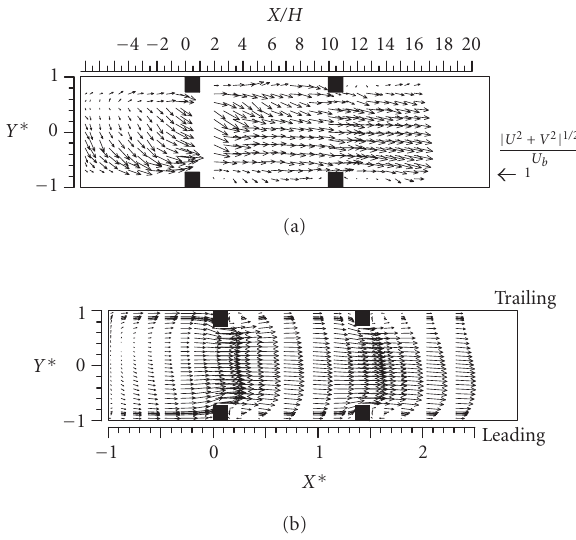
Figure 6: Mean velocity vector plots around the turn in the second pass on Z ∗∗ = − 0 . 5 for Ro = 0 . 15 and Re = 1 . 0 × 10 4 : (a) Liou et al. [1] and (b) present